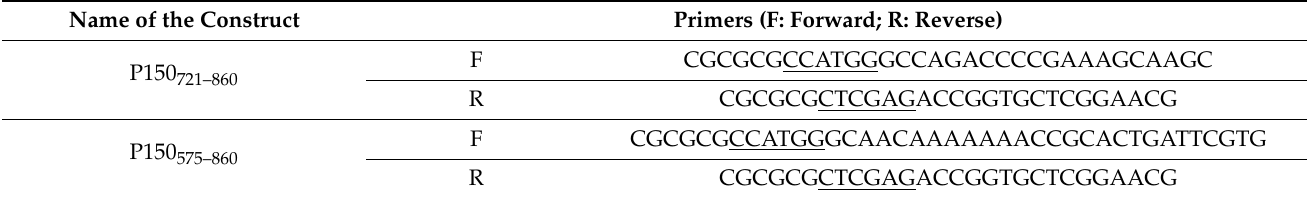
Table 1. List of the primers with the restriction site